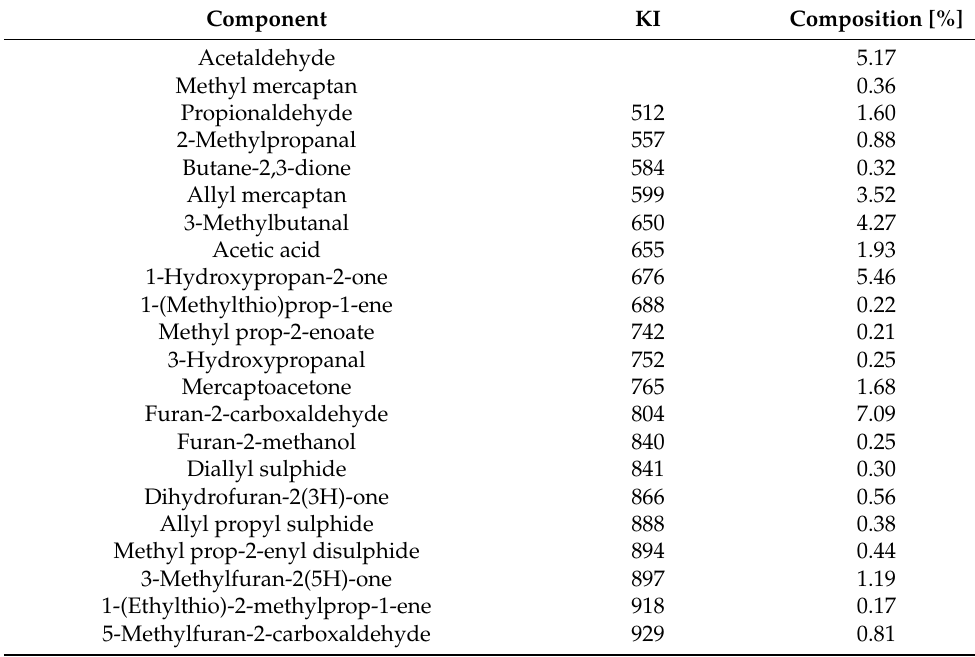
Table 2. Volatile compounds of Allium sativum L. water